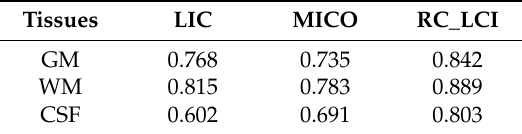
Table 2. JS of LIC, MICO, and